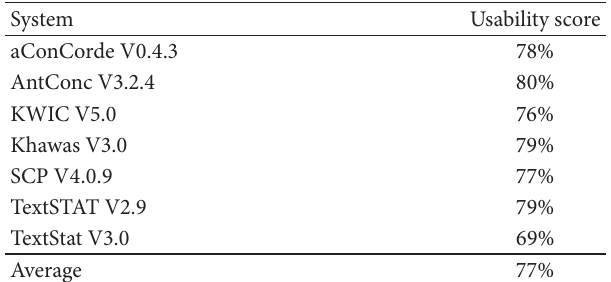
Table 2: Overall usability evaluation results for the seven corpora processing systems.